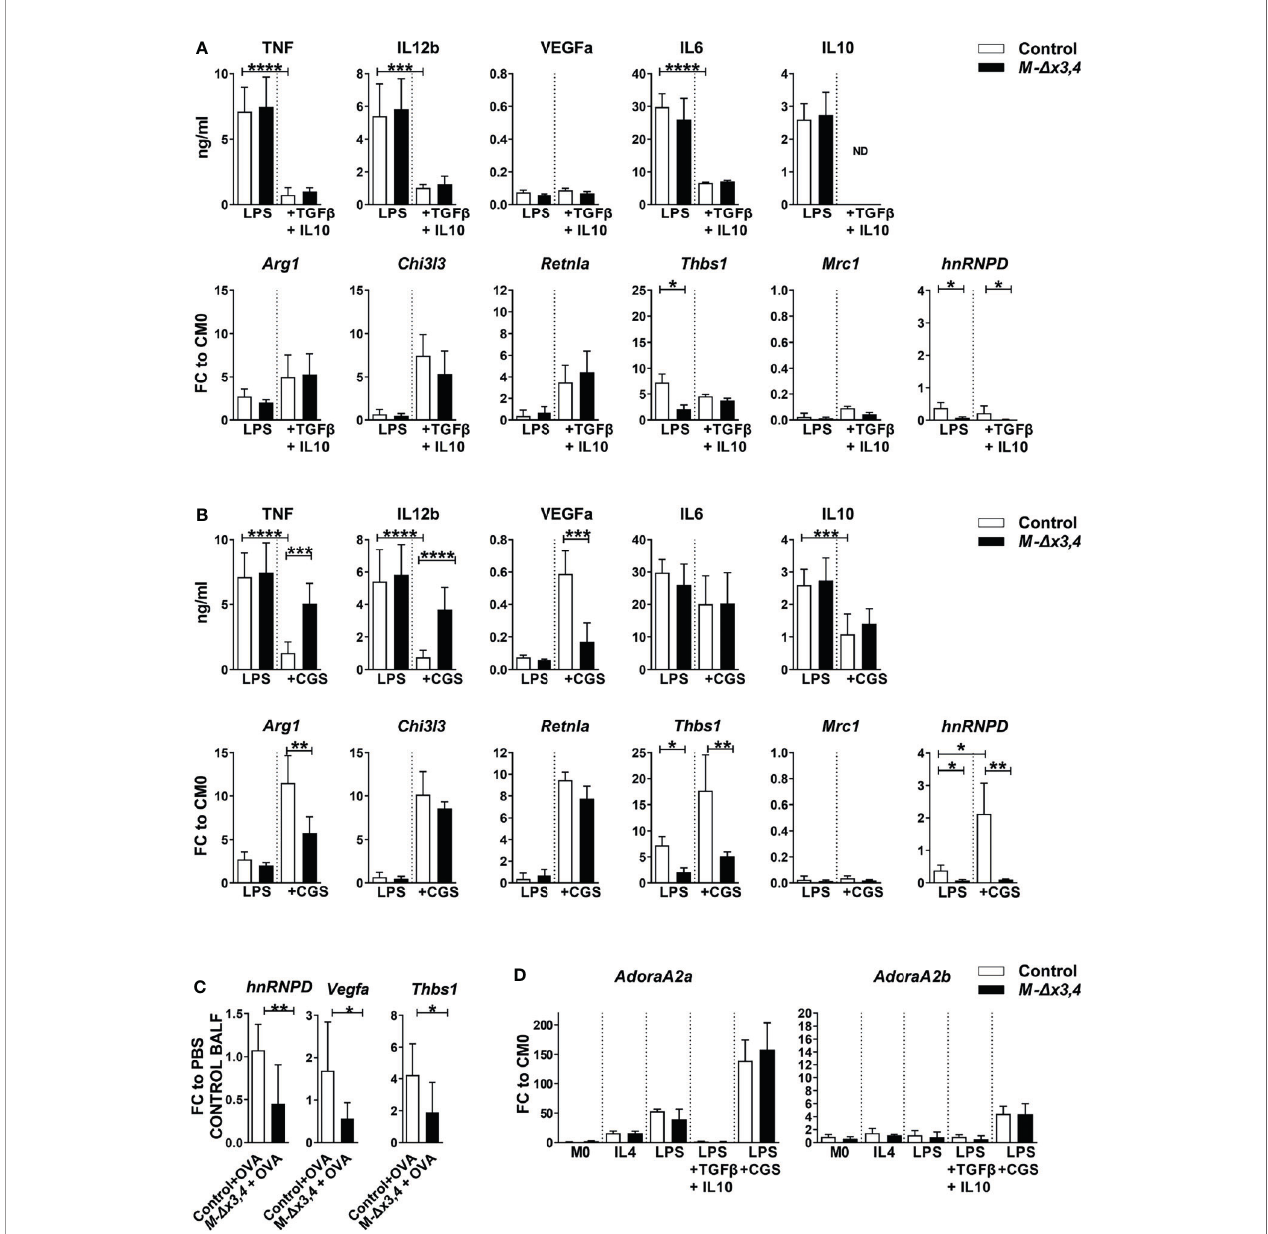
FIGURE 5 | Macrophages lacking AUF1s functions show defects in their transitions in response to adenosine receptor signals but not in response to TGF b and IL10. Quantitation of factors marking the classical or the alternative polarization of macrophages as well as detection of hnRNPD expression in response to (A) the combination of TGF b +IL10 and; (B) adenosine A2A receptor agonist (CGS) in LPS-activated control and M-hnRNPD D x3,4 BMDMs (n=10). Bar graphs denote mean values ( ± SD) of secreted proteins assessed via Cytometric bead arrays; or mean fold changes (FC) in mRNAs relative to resting control values (CM0) as assessed via qRT-PCR. (C) Detection of hnRNPD , Vegfa and Thbs1 mRNAs in BALF cells from OVA-treated samples (n=5-6) relative to untreated (PBS) values as assessed via q RT-PCR. (D) Quantitation of Adora2a and Adora2b mRNAs in control and M-hnRNPD D x3,4 BMDMs (n=10) in response to the indicated signals. Bar graphs denote mean values ( ± SD) or mean fold changes (FC) in mRNAs relative to resting control values (CM0) as assessed via qRT-PCR (*, **, ***, ****) denote p values ≤ 0.05, ≤ 0.001, ≤ 0.0001, ≤ 0.00001 respectively as determined via unpaired Student ’ s